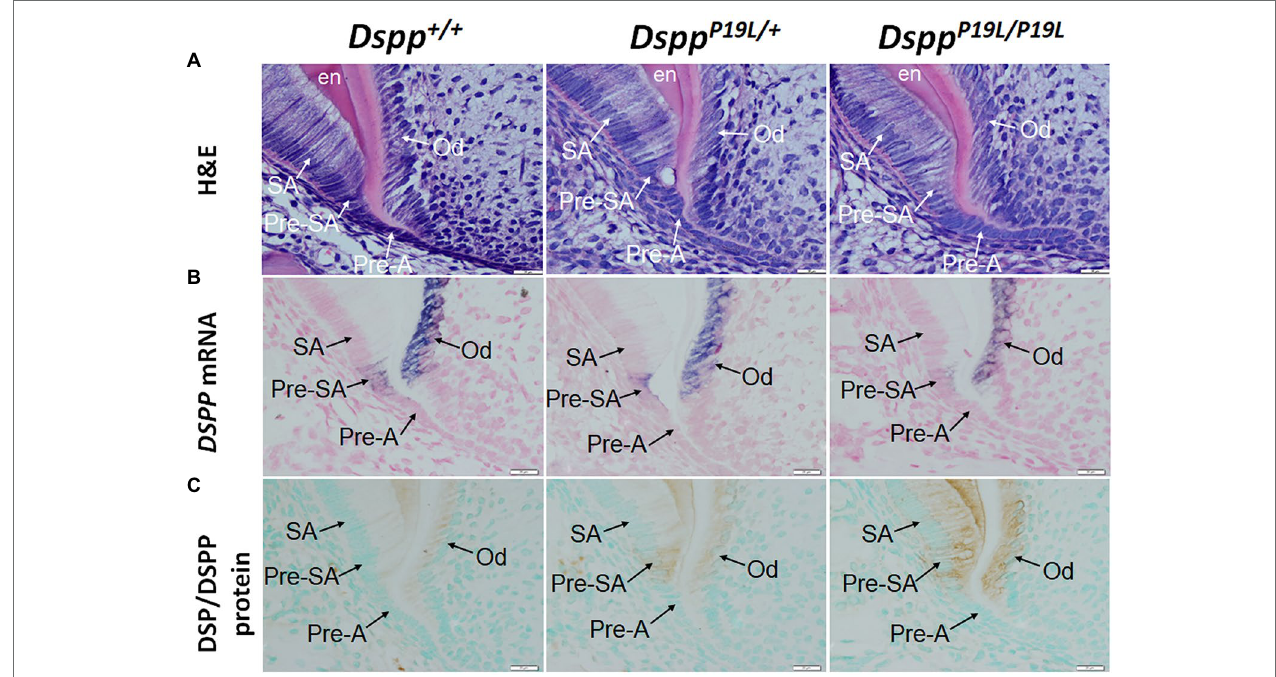
FIGURE 6 | Intracellular accumulation of dentin sialophosphoprotein (DSPP) protein in presecretory ameloblasts. All images are the sagittal section and distal cervical region of the mandibular first molars of 1-week-old wild-type Dspp +/+ , heterozygous Dspp P19L/+ and homozygous Dspp P19L/P19L mice. (A) H&E staining. (B) In situ hybridization analysis of DSPP mRNA (signal in purple). Dspp P19L/+ mice had a moderate decrease, whereas homozygous Dspp P19L/P19L mice showed a marked decrease in DSPP mRNA level in both odontoblasts and presecretory ameloblasts, compared to the wild-type mice. (C) Immunohistochemical staining of DSP/ DSPP protein (signal in brown). The immunohistochemical staining signals for DSP/DSPP protein were weakly detected in the presecretory ameloblasts and odontoblasts in the wild-type mice. There was a moderate increase in the DSP/DSPP signals in both presecretory ameloblasts and odontoblasts in Dspp P19L/+ mice, and a strong increase in Dspp P19L/P19L mice. SA, secretory ameloblasts; Pre-SA, presecretory ameloblast, Pre-A, preameloblasts; OD, odontoblasts; and en, enamel. Scale bars: 20 μ m in